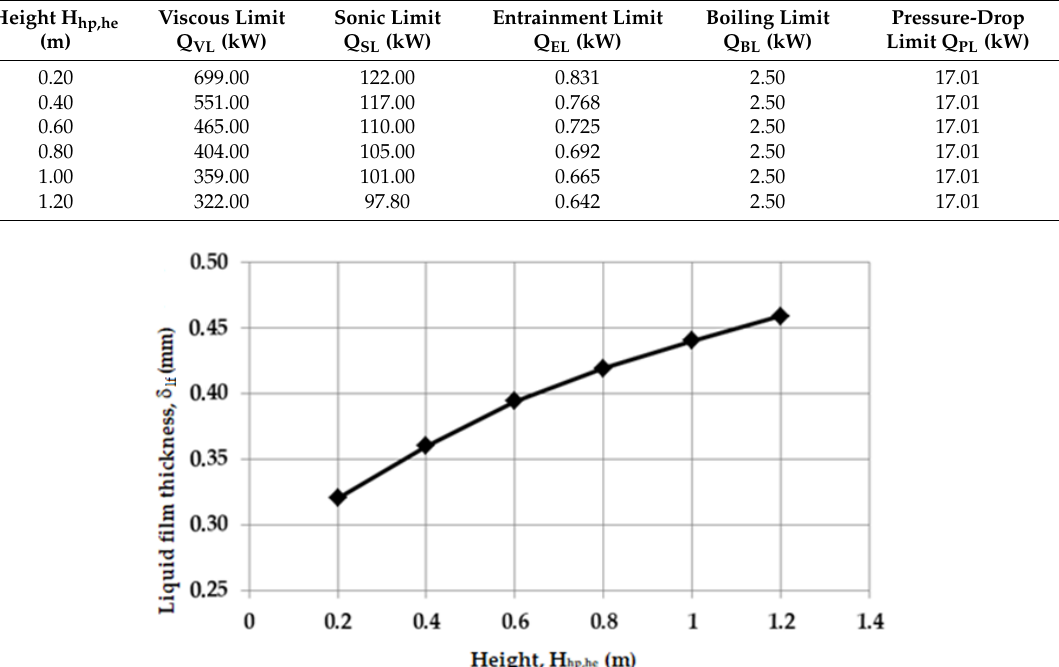
Figure 4. Impact of the height H hp-he on the liquid film thickness δ lf .